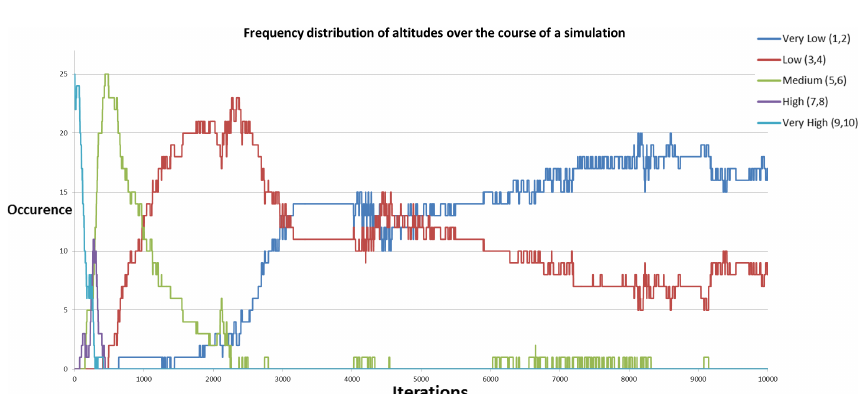
Figure 9. An aggregated version of the drones’